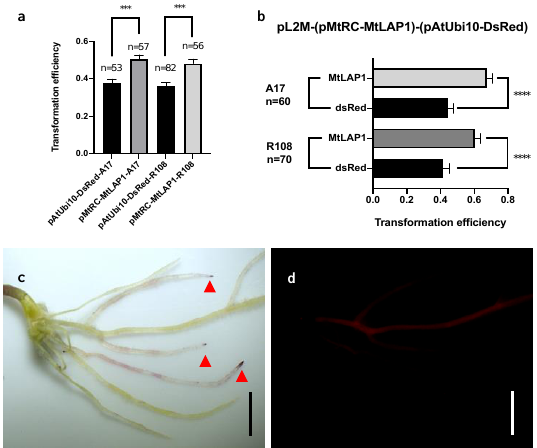
Figure 3. Transformation frequencies for pMtRC-MtLAP1 and pAtUbi10-DsRed on M. truncatula . ( a ) The frequency of plants having transformed roots using pAtUbi10-DsRed or pMtRC-MtLAP1; ( b ) The frequency of transformed roots per plant on those plants with at least one transgenic root with a vector containing both MtLAP1 and DsRed (pMtRC-MtLAP1 pAtUbi10-DsRed); ( c ) A17 transformed with pMtRC-MtLAP1 pAtUbi10-DsRed, red arrows indicate roots with purple tips that show either very weak or no DsRed fluorescence; ( d ) Same roots as in ( c ) under a fluorescent microscope. Bars are 2.5 mm in ( c , d ). Error bars in ( a , b ) are SEMs. Student’s t -test was used for statistical analyses, *** p < 0.001 and **** p < 0.0001.